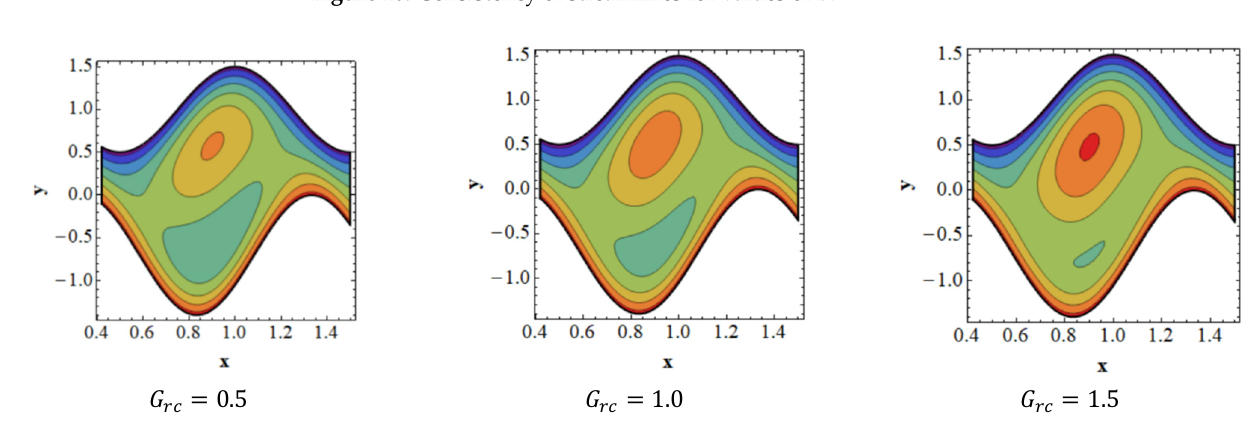
Figure 11. Consistency of streamlines for values of G rc